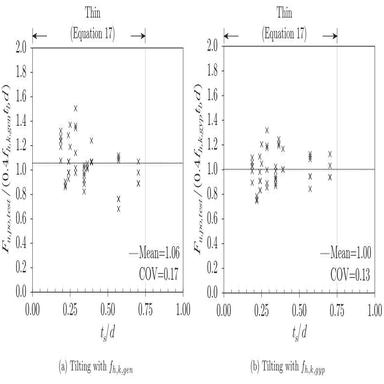
Comparisons between test and predicted Fu,po values calculated using Eq. Mode a (screw tilting) with embedment strength (a) fh,k,gen (Eq.)) and (b) fh,k,gyp (Eq. for all screwed connections in plasterboard with the thin plate limit extended to ts/d ≤ 0.75.